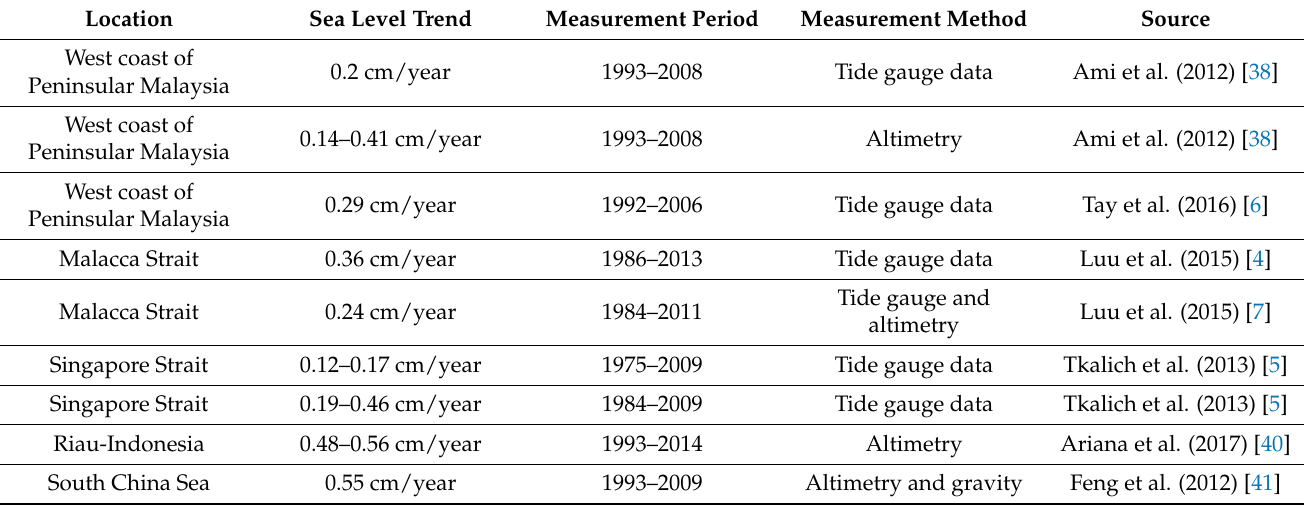
Table 2. Reports of sea level trend in the surrounding Malacca